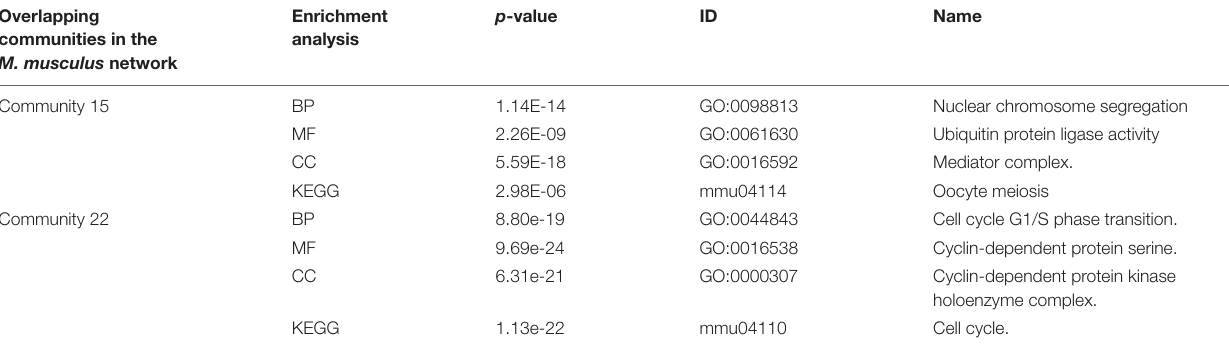
TABLE 5 | Enrichment analysis of an overlapping structure in the H. sapiens network. Overlapping communities in